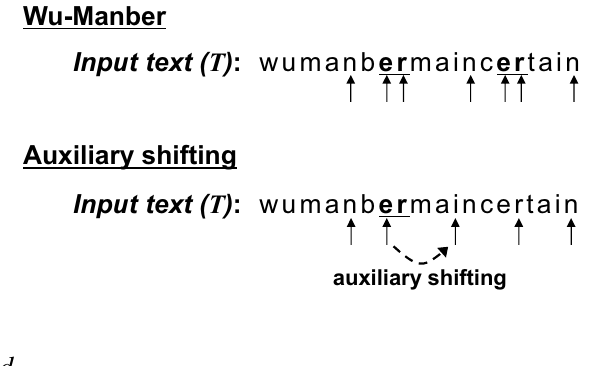
Figure 4. Examples of matching procedures for Wu–Manber (WM) and auxiliary